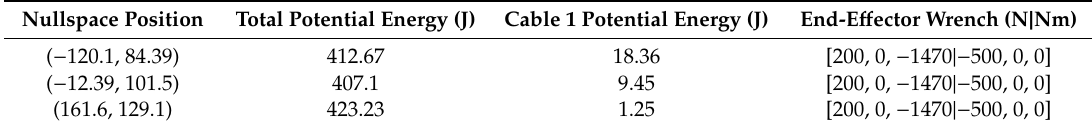
Table 3. End-e ff ector wrench for each tension distribution ( δ 8 = 0.447 m )